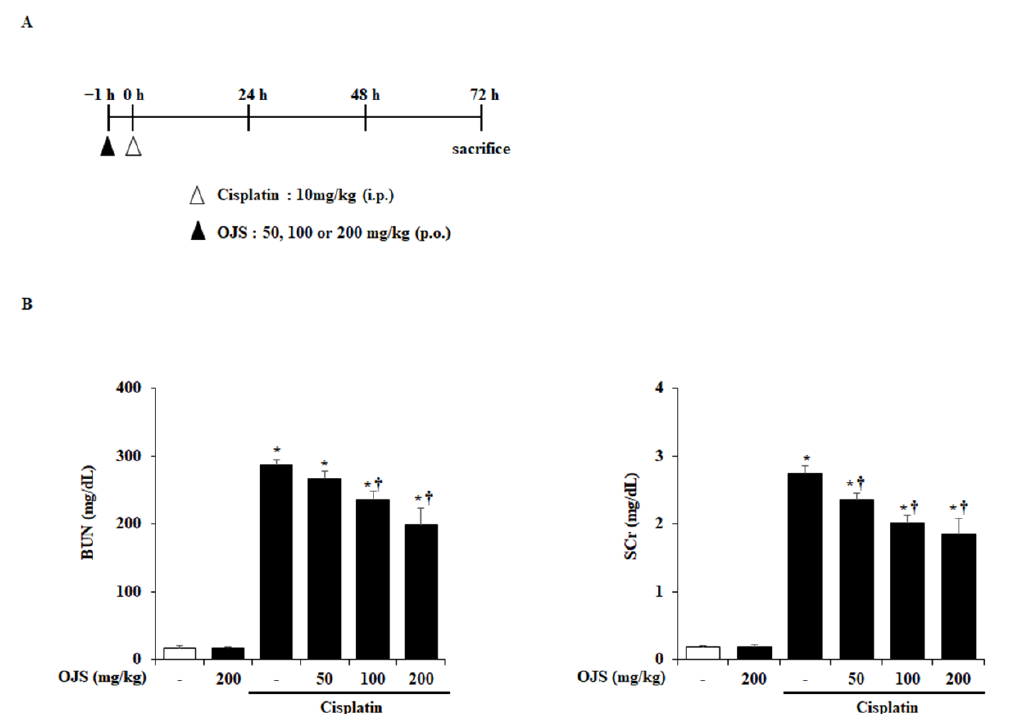
Figure 1. OJS treatment reduces BUN and SCr levels in cisplatin-induced AKI. ( A ) Mice orally administered saline or OJS (50, 100, or 200 mg/kg) were intraperitoneally injected with cisplatin (20 mg/kg). They were euthanized at 72 h after the cisplatin injection. ( B ) BUN and SCr were measured in blood serum. Data are provided as mean ± S.E.M. ( n = 27) (* indicates p < 0.05 vs. saline-treated control group, † indicates p < 0.05 vs. cisplatin treatment